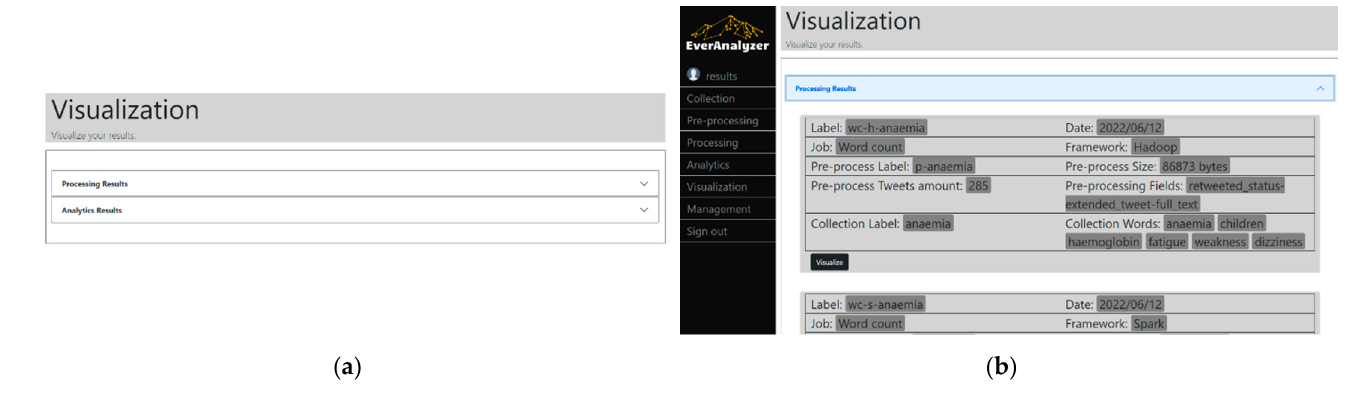
Figure 21. ( a ) Visualization lists; ( b ) Visualizable results.